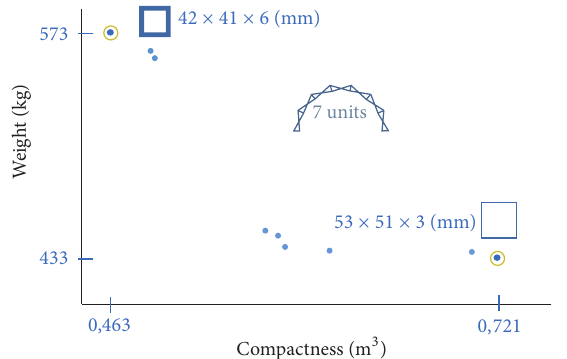
Figure 5: The Pareto front obtained for 60 individuals and 20 gener- ations shows the conflicting behaviour of weight and compactness. A small cross section procures a compact solution, but, to meet constraints, the cross section must be thicker, which causes heavier solutions (and vice versa).